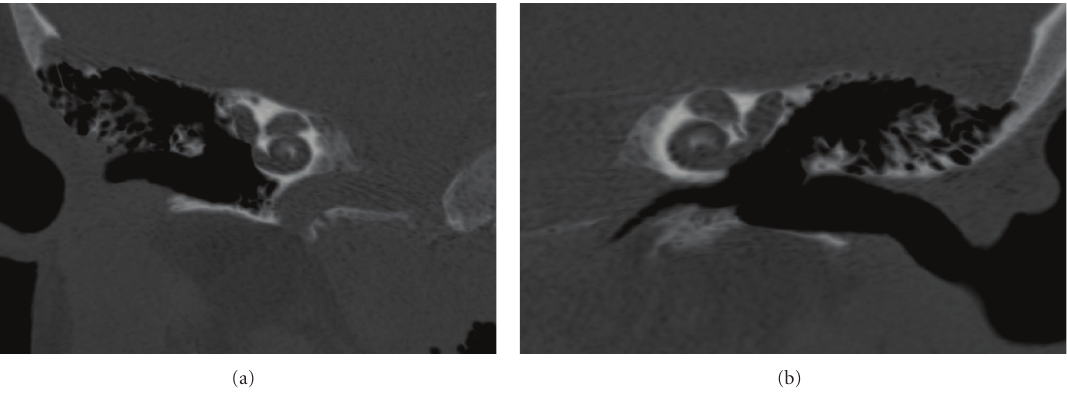
Figure 3: Right (a) and left (b) coronal oblique reformation of the mastoid, using minimal intensity projection. Note the dysplastic morphology of the vestibule and the absence of semicircular canals. The cochlea has normal